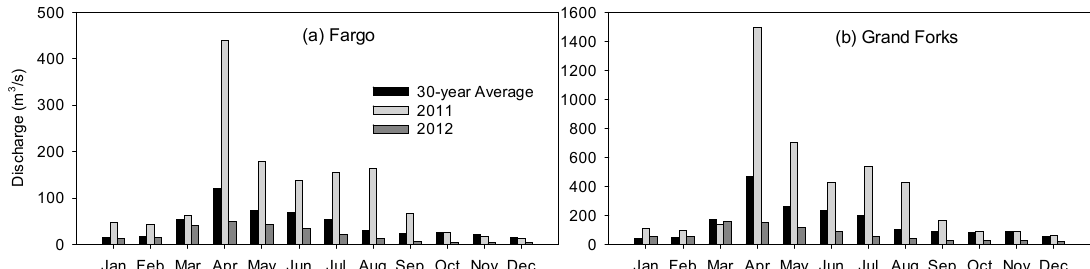
Figure 2. Monthly average discharges for 2011, 2012, and a 30-year period (1988–2017) at ( a ) Fargo station, and ( b ) Grand Forks station.